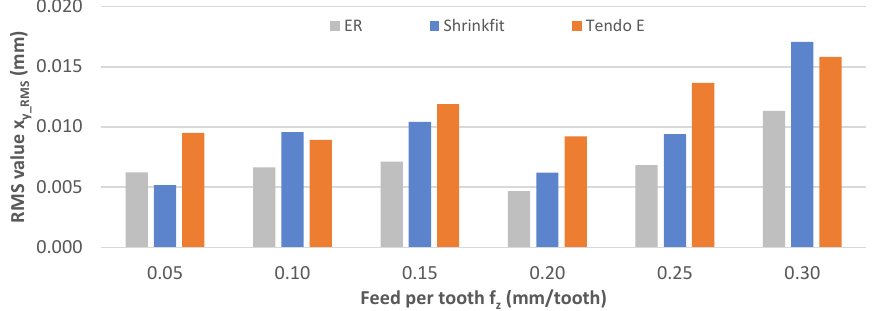
Figure 11. Impact of feed per tooth f z on the rms vibration displacement value x y_RMS (v c = 800 m/min, a p = 6 mm).